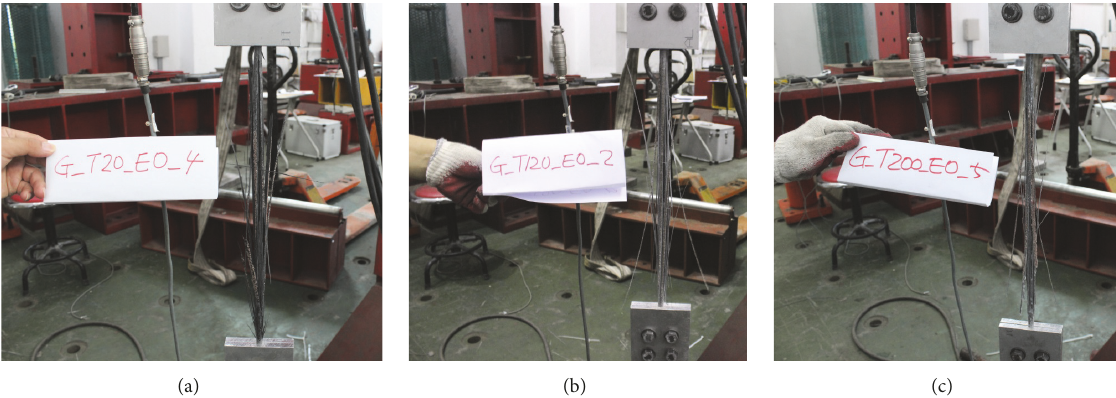
Figure 12: Failure of testing specimens without alkaline solution immersion: (a) exposed to room temperature, (b) exposed to 120 ∘ C, and (c) exposed to 200 ∘ C.